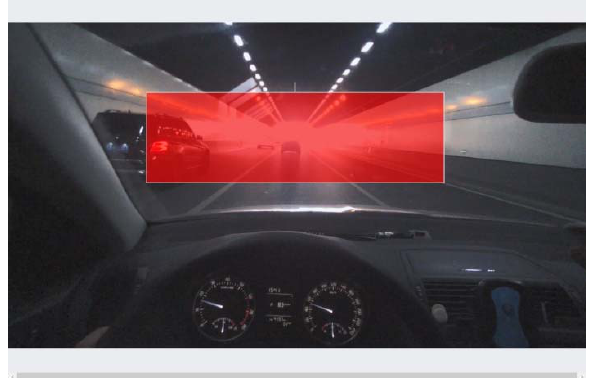
Figure 11. Safe gaze area.